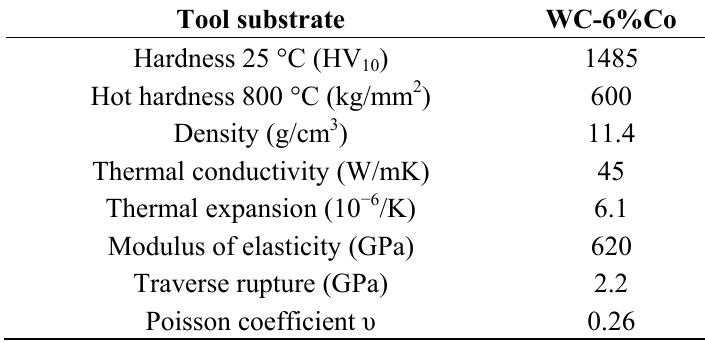
Table 3. Mechanical and thermal properties of the cutting tool substrate